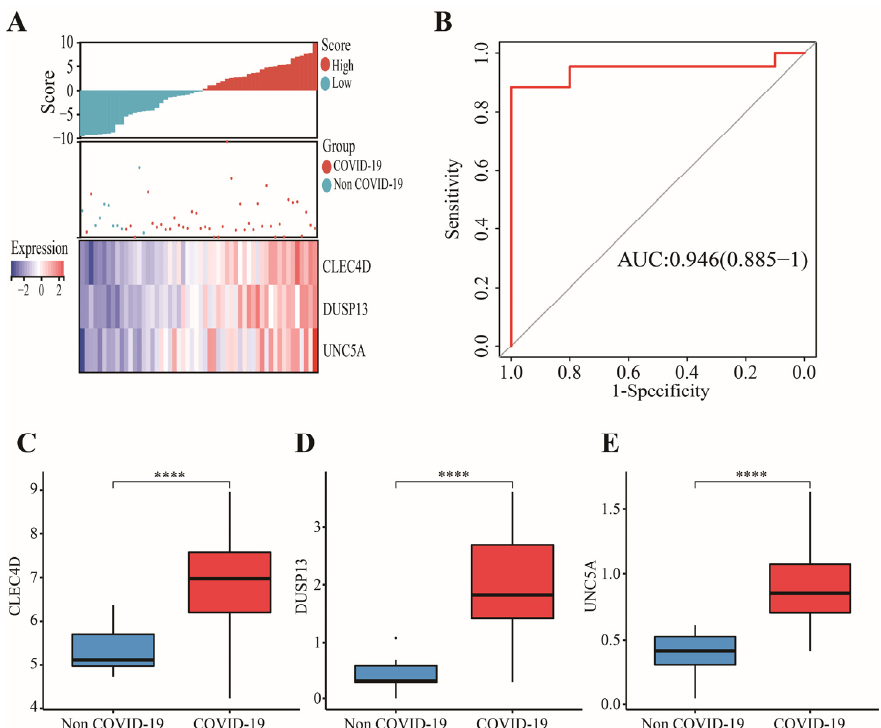
Figure 8. Validation of a 3-gene signature in GSE171110. ( A ) Different outcomes and expressions of CLEC4D, DUSP13, and UNC5A between high- and low-score groups. ( B ) The AUC for prediction of outcome. ( C – E ) The expressions of CLEC4D, DUSP13, and UNC5A between COVID-19 and non-COVID-19 groups. Data in ( C – E ) were analyzed by Wilcoxon test; ns, no significance; **** p < 0.0001.